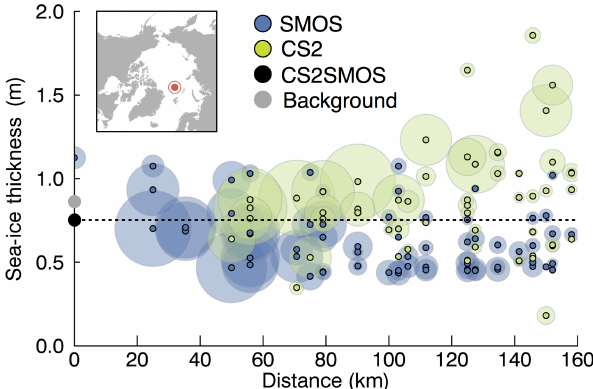
Figure 8. Example for CS2 and SMOS sea-ice thickness observa- tions and their weighting to compose the CS2SMOS thickness es- timate based on optimal interpolation at a grid cell in the Central Arctic first-year ice in November 2016. The x axis represents the distance of observations from the analysis grid cell. Normalized K weights are represented by the area of the